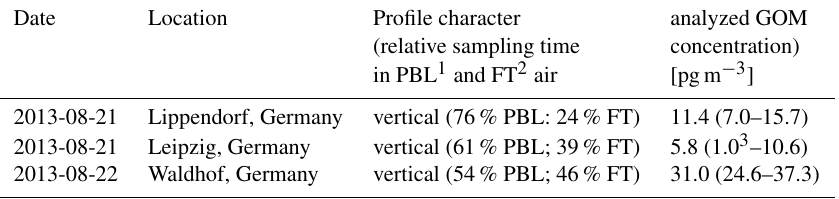
Table 6. Results of the manual KCl denuder samples during all ETMEP-2 measurement flights in 2013 over central Europe. GOM data were corrected for denuder blanks determined over Iskraba, Slovenia, and Waldhof, Germany. GOM concentrations are given as a center of an estimated uncertainty range (in brackets) and are given at standard temperature and pressure (STP; T = 273.15K, p =